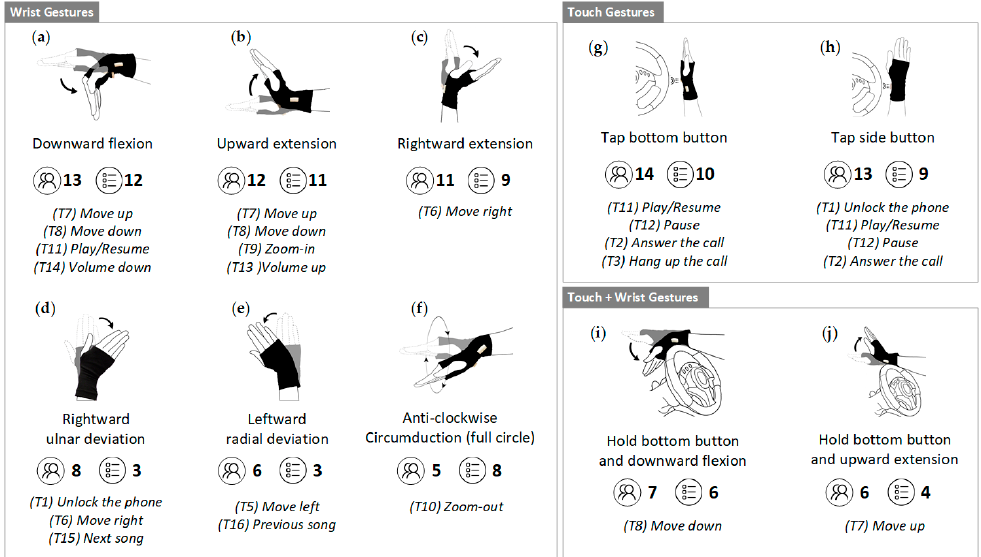
Figure 4. Consensus in-vehicle gesture set: ( a ) downward flexion; ( b ) upward extension; ( c ) rightward extension; ( d ) rightward ulnar deviation; ( e ) leftward radial deviation; ( f ) anti-clockwise circumduction; ( g ) tap bottom button; ( h ) tap side button; ( i ) hold bottom button and downward flexion; and ( j ) hold bottom button and upward extension. Downward flexion was performed by 13 participants for 12 commands. (T7) Move up command was more frequently performed using downward flexion. Gestures are referenced and discussed in the design guidelines